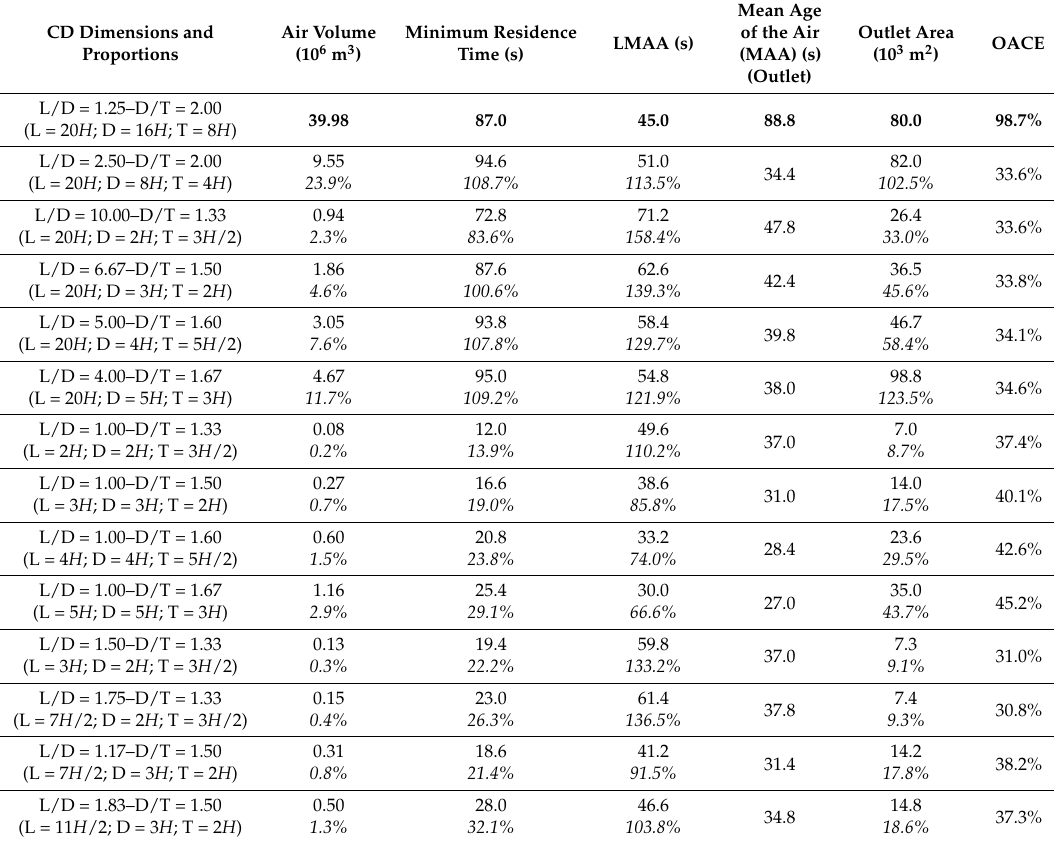
Table 4. Results for CD dimensions and proportions.